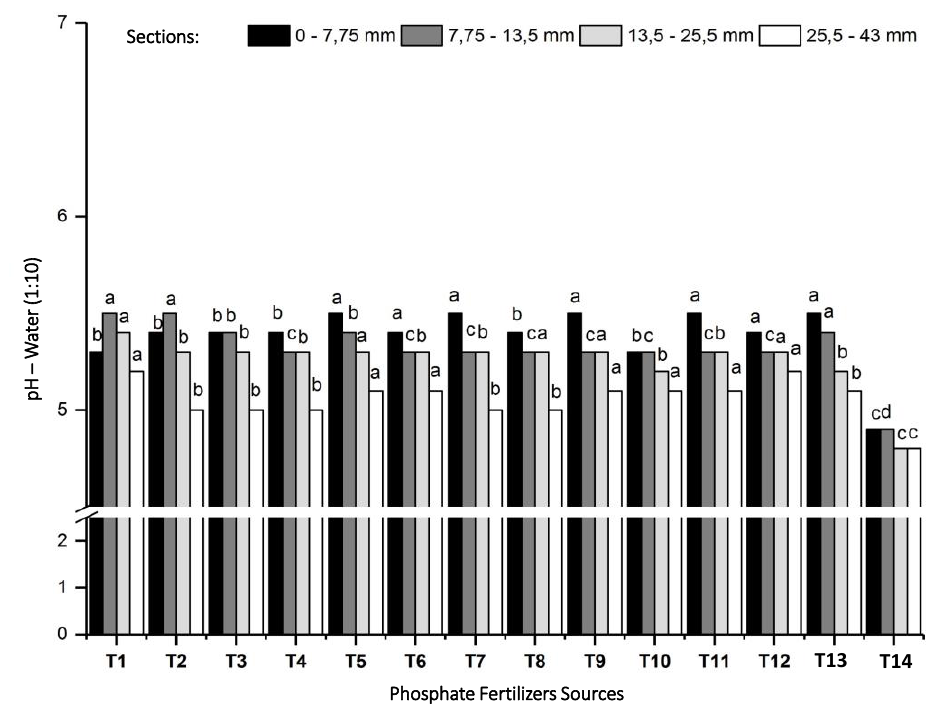
Figure 3. Soil pH as function of fertilizer source and soil layer after five weeks of incubation. Mean values followed by the same letter in the same layer do not differ by t -test (Scott-Knott, P < 0.05). T1 = ARP + PILC + 50% Ac.; T2 = ARP + PILC + 25% Ac; T3 = ARP + Zeo + 50% Ac; T4 = ARP + Zeo + 25%Ac.; T5 = BRP + PILC + 50%Ac.; T6 = BRP + PILC + 25%Ac.; T7 = BRP + Zeo + 50% Ac; T8 = BRP + Zeo + 25% Ac; T9 = MRP + PILC + 50% Ac.; T10 = MRP + PILC + 25% Ac.; T11 = MRP + Zeo + 50% Ac.; T12 = MRP + Zeo + 25% Ac.; T13 = TSP (triple superphosphate); T14 = control. ARP = Arax á rock phosphate; BRP = Bayovar rock phosphate; MRP = Morocco rock phosphate; PILC = pillared clay; Zeo =